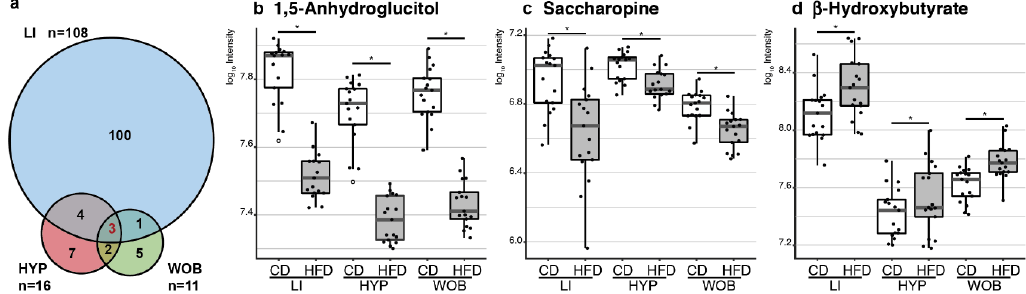
Figure 4. Post-weaning HFD discriminated several metabolites in the three tissues. ( a ) Venn diagram representing the number of metabolites discriminating between CD-fed and HFD-fed male mice. Abundance of the three metabolites affected similarly in the three tissues is represented as boxplot, with dots showing individual measurements, and white dots are outliers. ( b ) HFD-fed mice had significantly lower anhydroglucitol levels and ( c ) saccharopine levels than CD-fed mice. ( d ) HFD-fed mice had significantly higher β -hydroxybutyrate levels than CD-fed mice. * Indicates an adjusted p -value < 0.05.